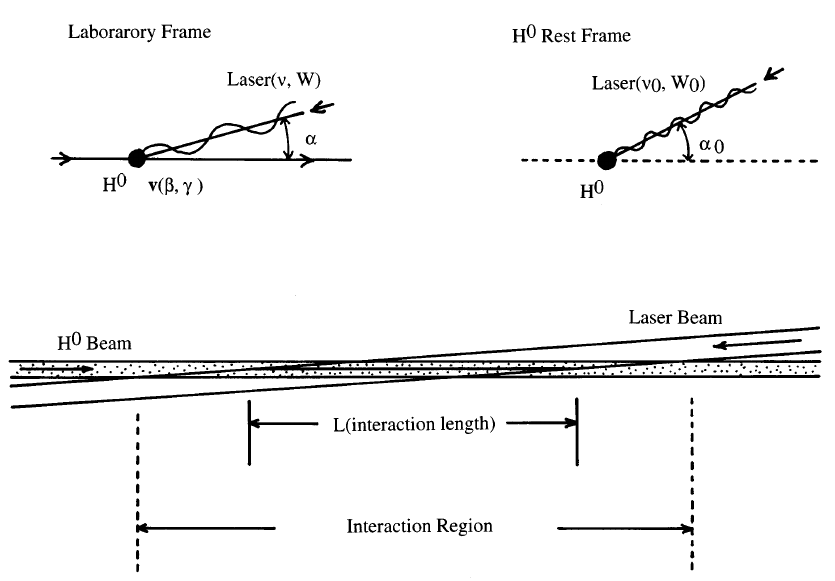
FIG. 2. Colliding system of an H (cid:48) atom beam and a laser beam. Variables in the H (cid:48) rest frame are shown in the upper right and those in the laboratory frame are shown in the upper